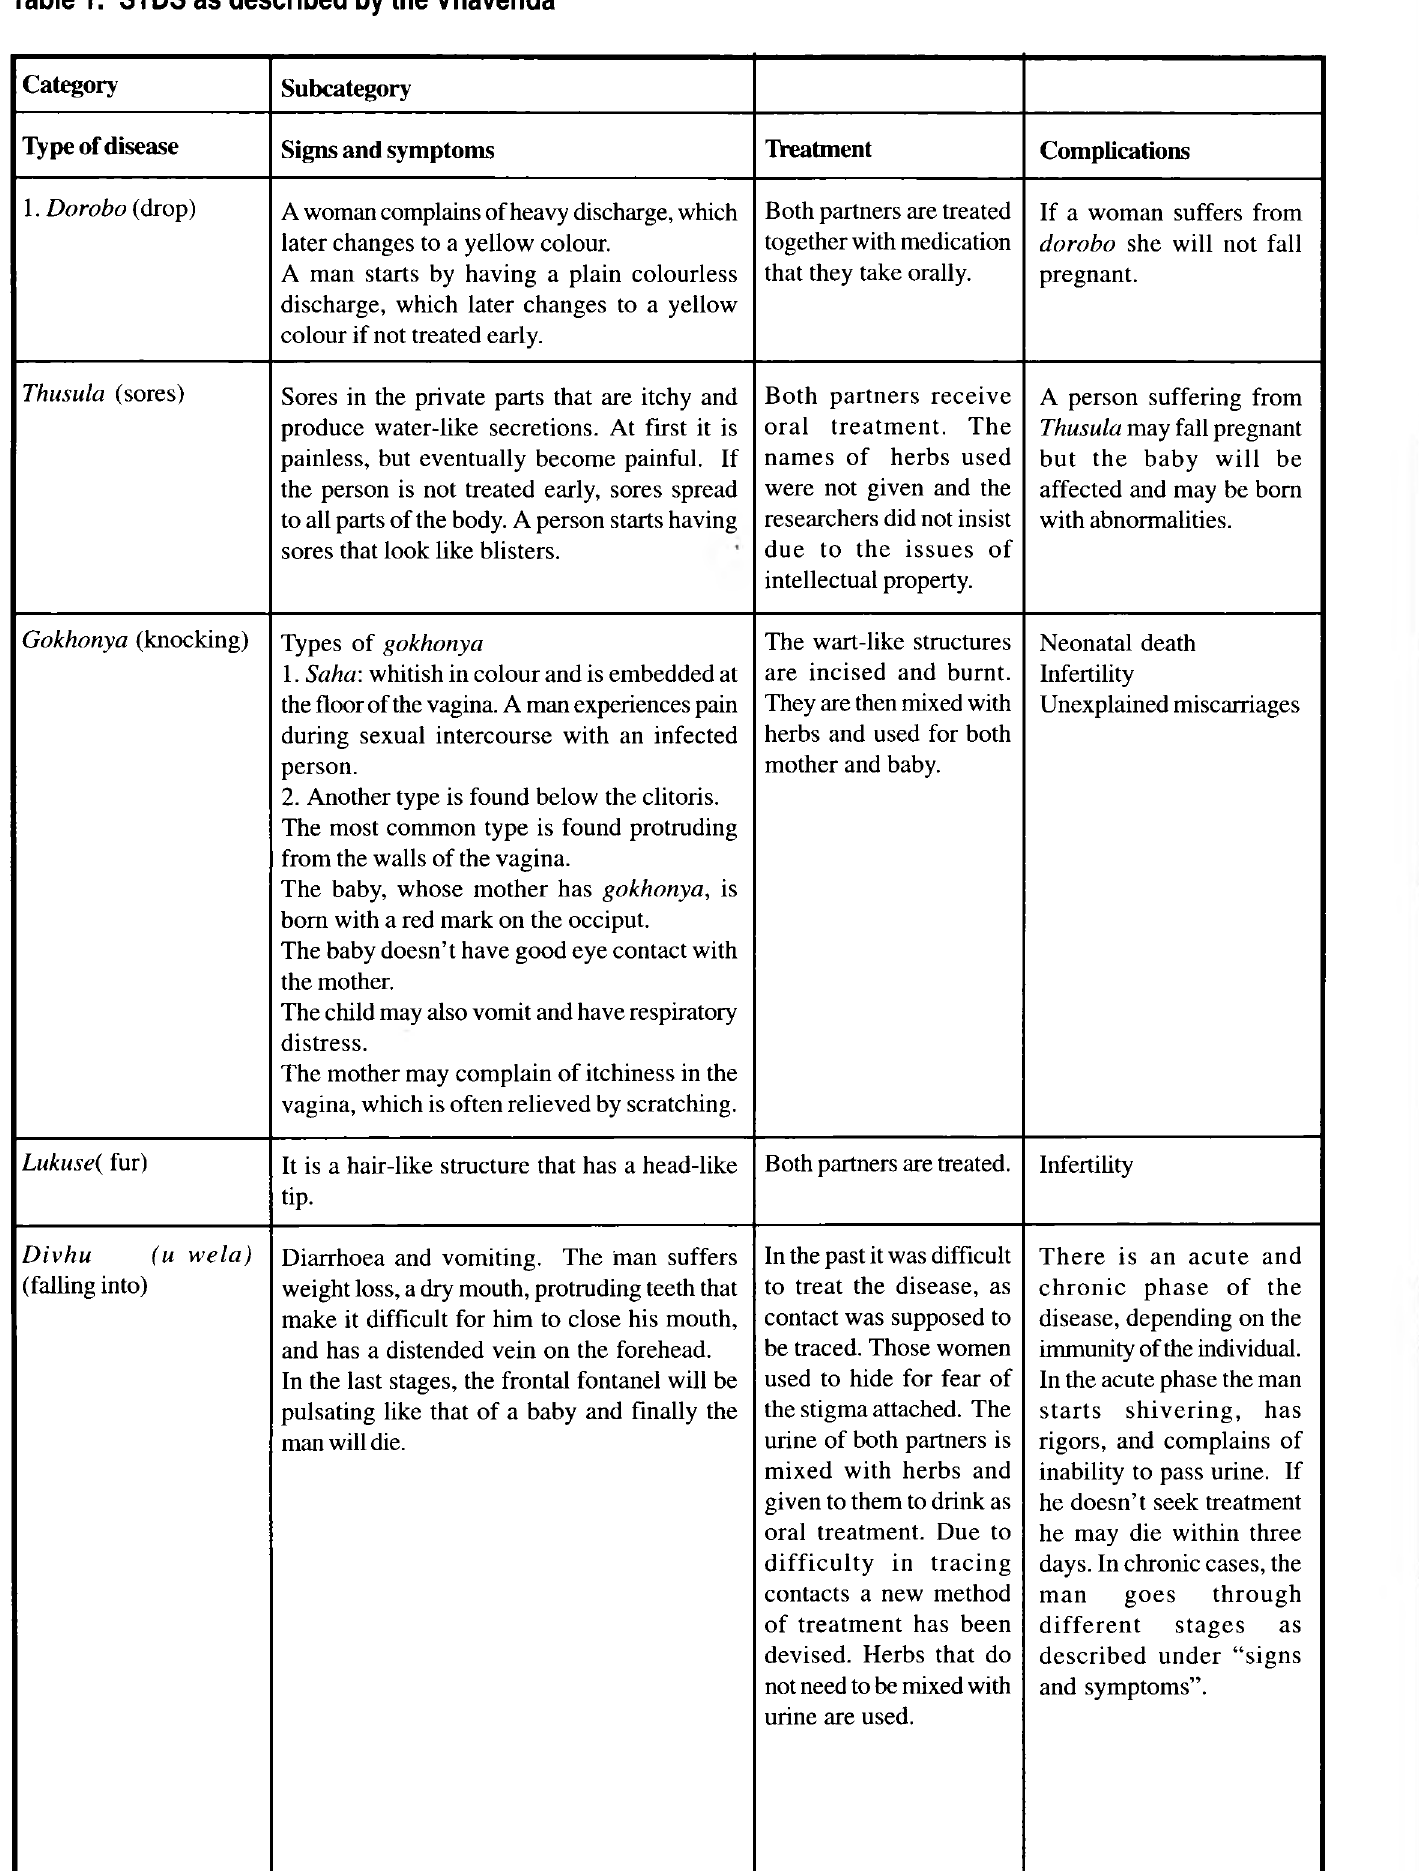
Table 1: STDS as described by the Vhavenda